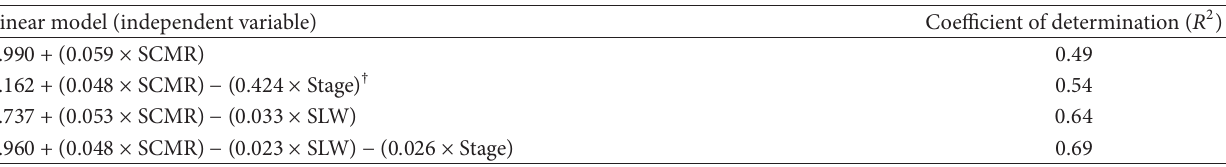
Table 4: Equations are developed by linear regression to estimate leaf N concentration, using different combinations of SPAD chlorophyll meter reading (SCMR) values, growth stage (Stage), and specific leaf weight